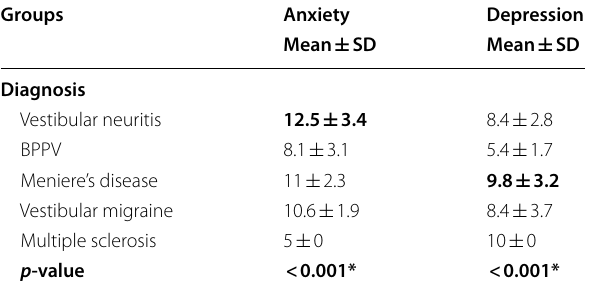
Table 6 Correlation between anxiety and depression with age, disease duration, and DHI